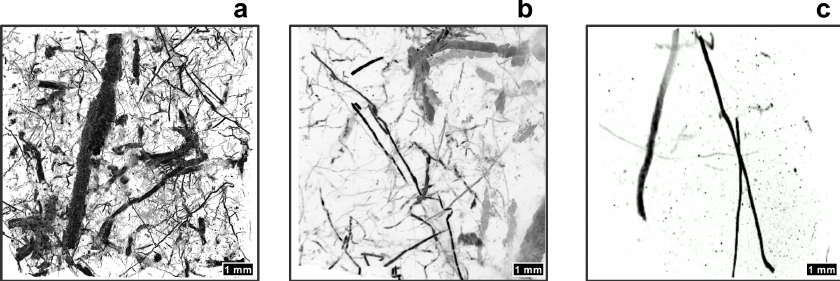
Figure 2. X-ray computed microtomography scanner images of different parts of Trichichnus spatial complex, Oligocene, Skole Nappe, Polish Flysch Carpathians: (a) Dense Trichichnus fabric, similar to the upper part of the Thioploca mat system. (b) Trichichnus fabric comparable with the middle part of the Thioploca mat system. (c) Trichichnus fabric depicting the lower part of the Thioploca mat